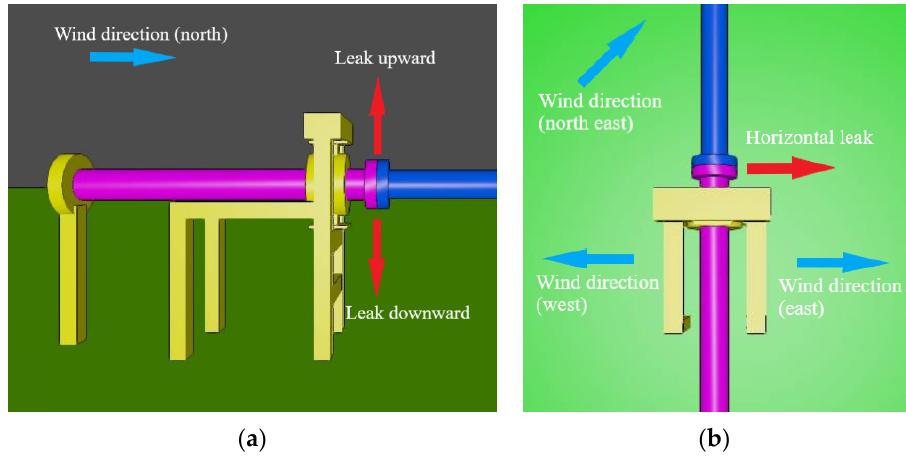
Figure 2. ( a ) Section view of the manifold showing two vertical leaks and wind directions; ( b ) plane view of the manifold showing the horizontal leak and wind directions.